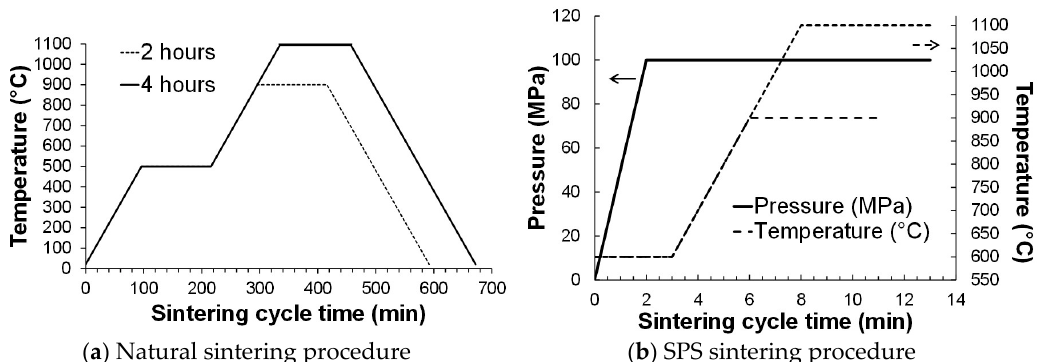
Figure 2. Sintering procedure for ZnO nanopowders ( a ) by the conventional way, and ( b ) by Spark Plasma Sintering (SPS).